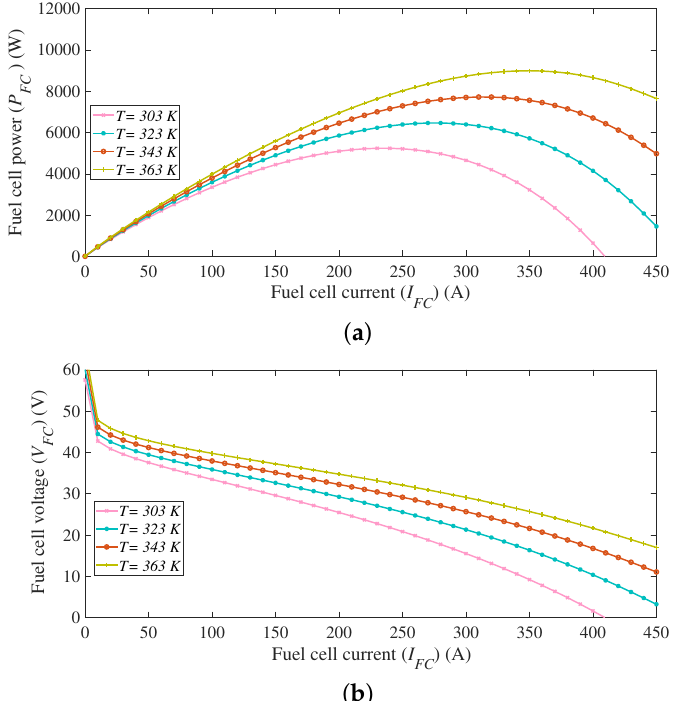
Figure 4. Modeled PEMFC curves at temperature variations with a constant value of water content ( λ m = 12 ) ; ( a ) P FC - I FC ; ( b ) V FC - I FC .